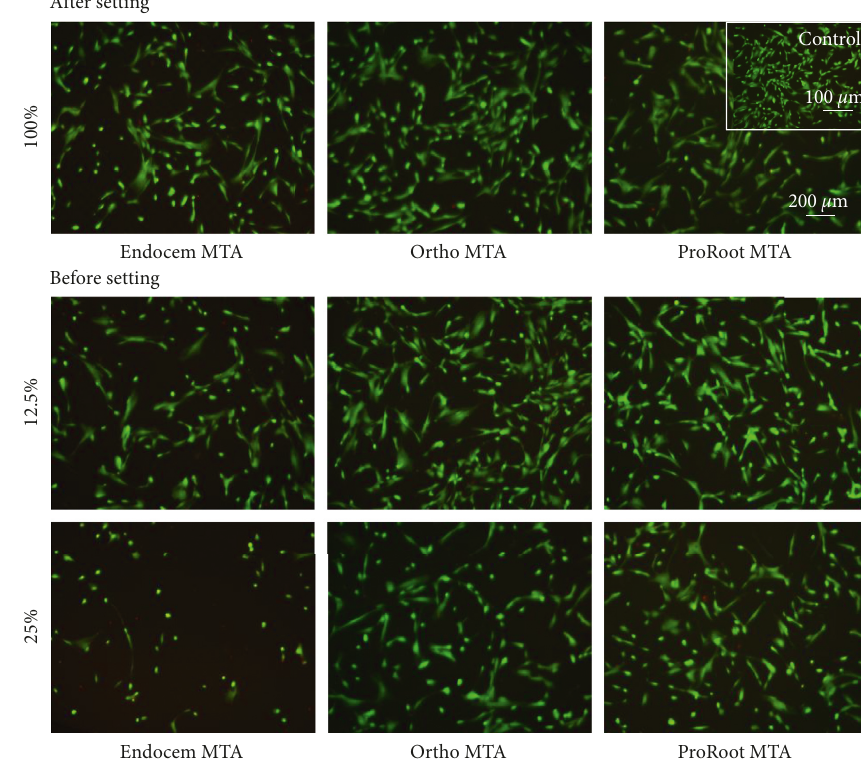
Figure 4: Live and dead cells of hMSCs exposed to 12.5% and 25% concentrations of extracts from each MTA before and after setting. Live (green) and dead (red) cells were observed by the fluorescent microscope. Washing steps were performed before live and dead staining to make sure that only intact live cells remained on the plate. Because the dead cells (red colored) were easily detached during the washing step, they are hardly seen in the current